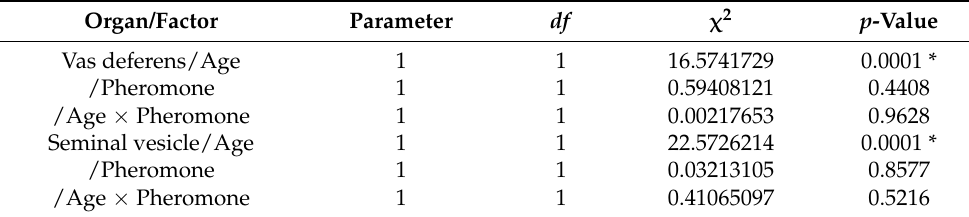
Table 6. The results of ordinary logistic regression analysis on the effects of pheromones and adult age on sperm distribution in the vas deferens and seminal vesicle of the desert locust Schistocerca gregaria . Organ/Factor